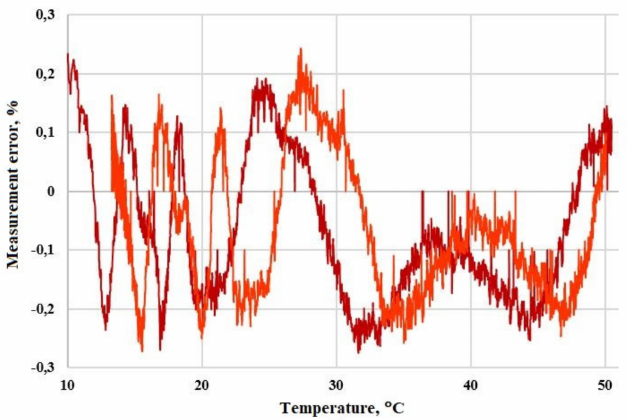
Figure 11. Relative amplitude error of FOCS after temperature compensation vs. temperature of the quarter-wave plate. Di ff erent colors correspond to heating and cooling. The primary current was 50% of the nominal value.